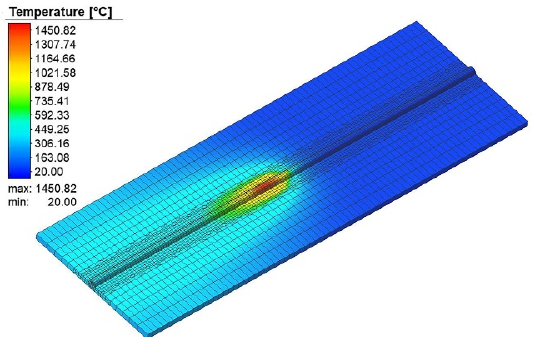
Figure 3. The temperature profile during the weld simulation .